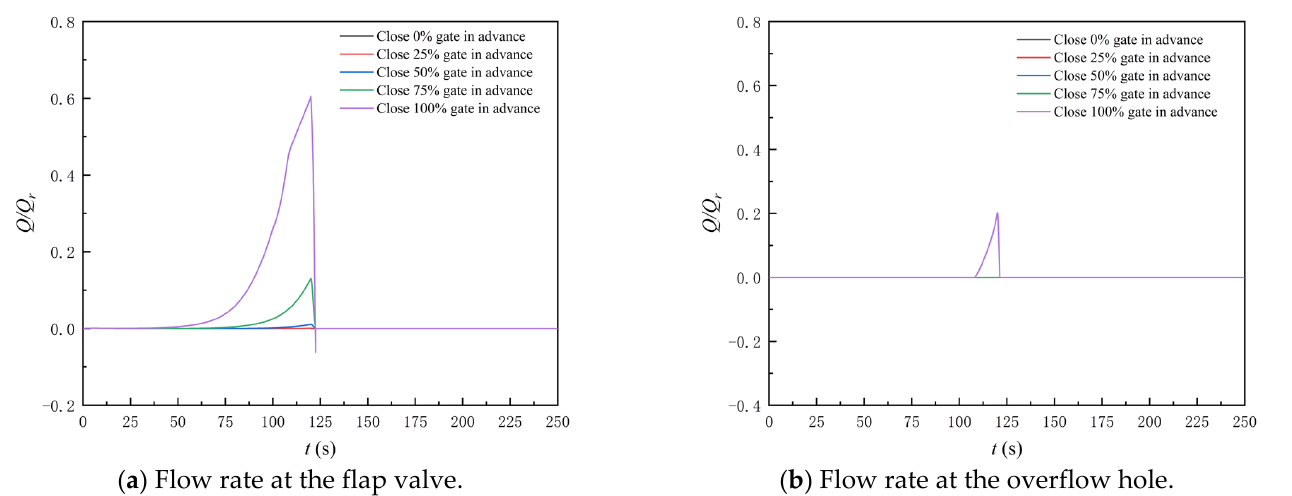
Figure 21. Flow at the flap gate and overflow hole when different gate closing schemes were adopted (TTGC: 60 s).